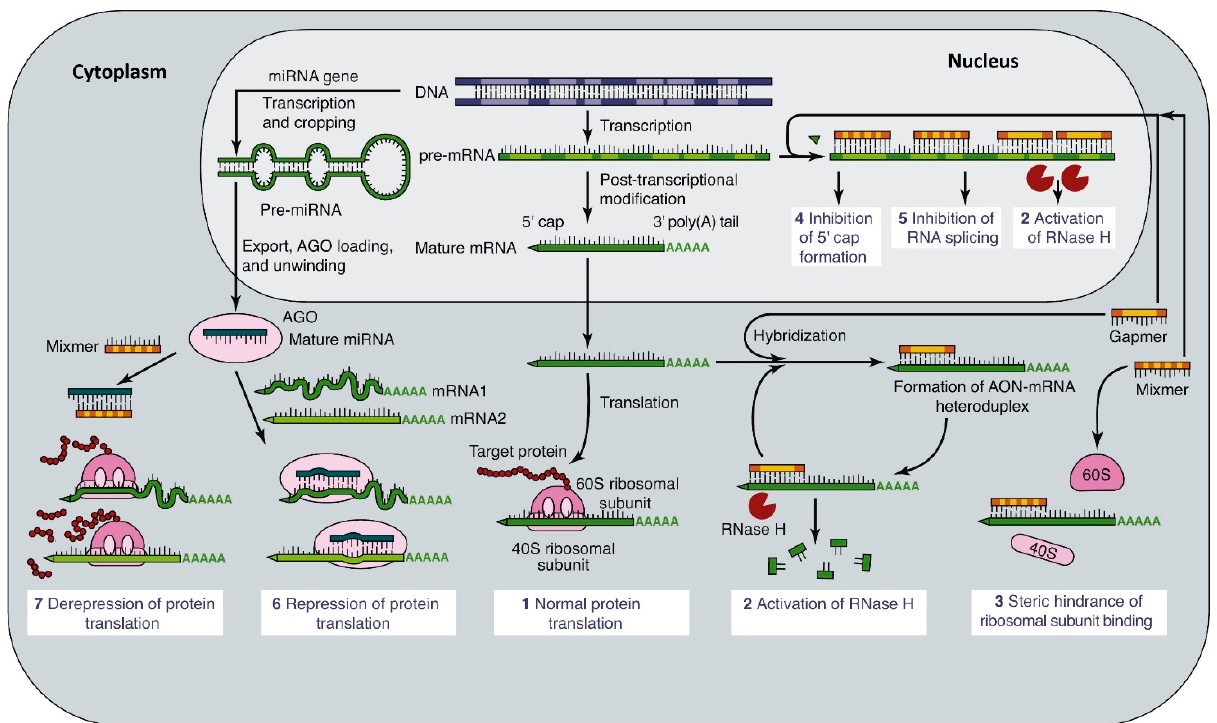
Figure 2. Summary of the ways in which antisense oligonucleotides can modulate normal gene expression (1). Binding of ASOs to mRNA produces double-stranded segments susceptible to cytoplasmic RNAse-H (2). Binding of ASOs to the 5 ′ or translated segments of mRNA interferes with ribosomal assembly or translation (3). In the nucleus, ASOs binding to the primary transcript can inhibit cap formation (4), polyadenylation or splicing (5), with the potential to act as a substrate for RNAse H. MiRs processed by the RISC complex (or directly transfected siRNA) can inhibit translation by binding to the mRNA (6), or siRNA can derepress translation by interfering with the binding of the mRNA with lncRNAs that inhibit mRNA availability (7). Adapted from Figure 1 in Hagedorn et al. [24].